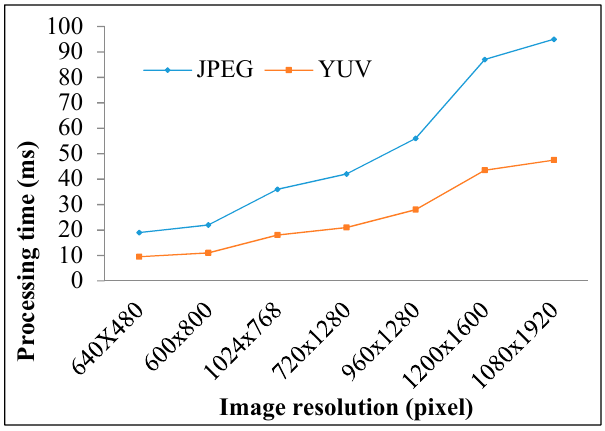
Figure 23. Processing performance vs. image sensor resolution.